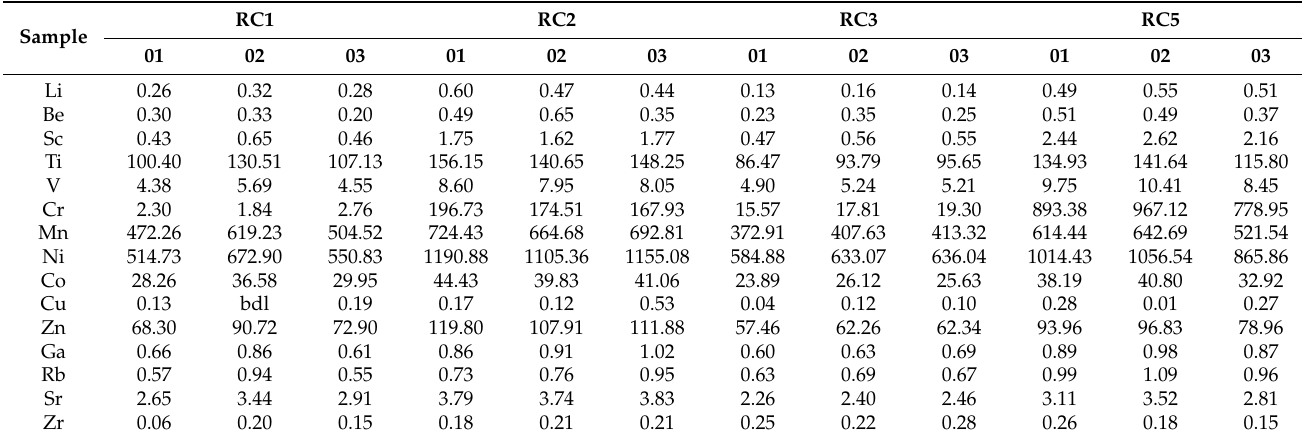
Table 2. Trace element data of the selected samples